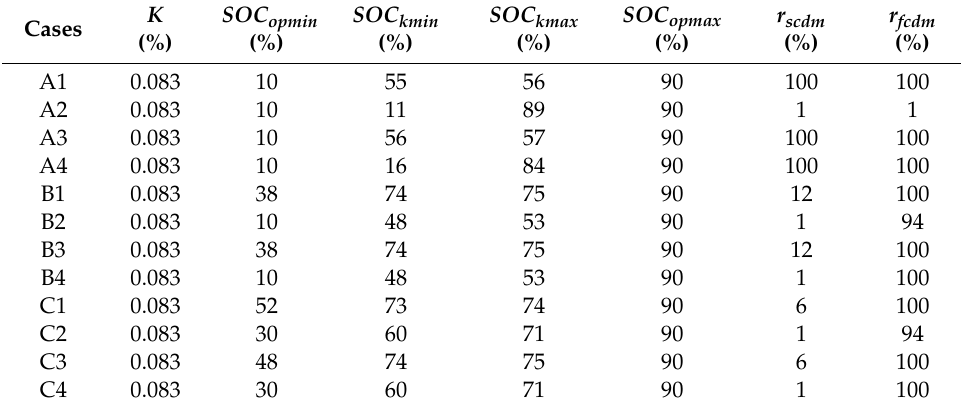
Table 5. Optimal parameter values for each case.